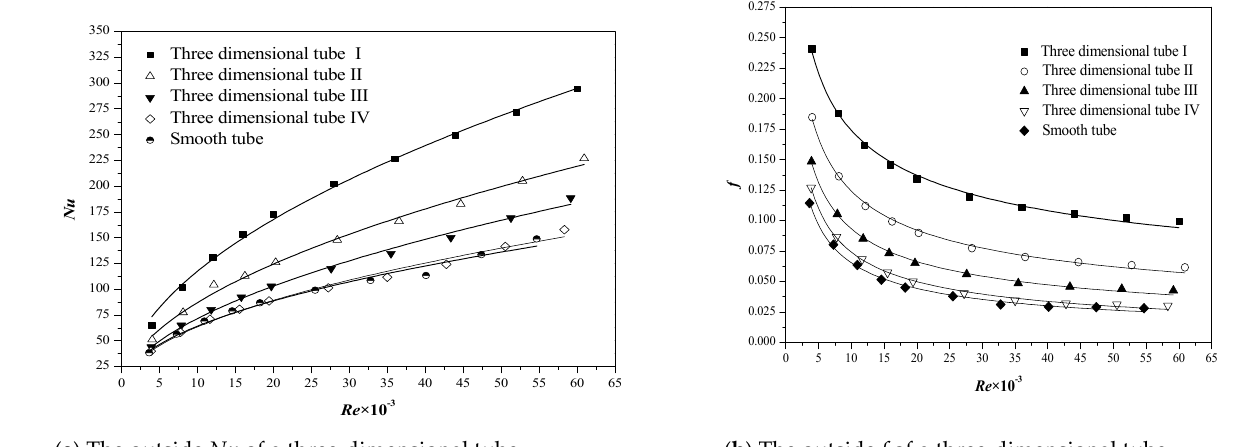
Figure 4. Curves of Nu and f outside three-dimensional tube changing with Re .